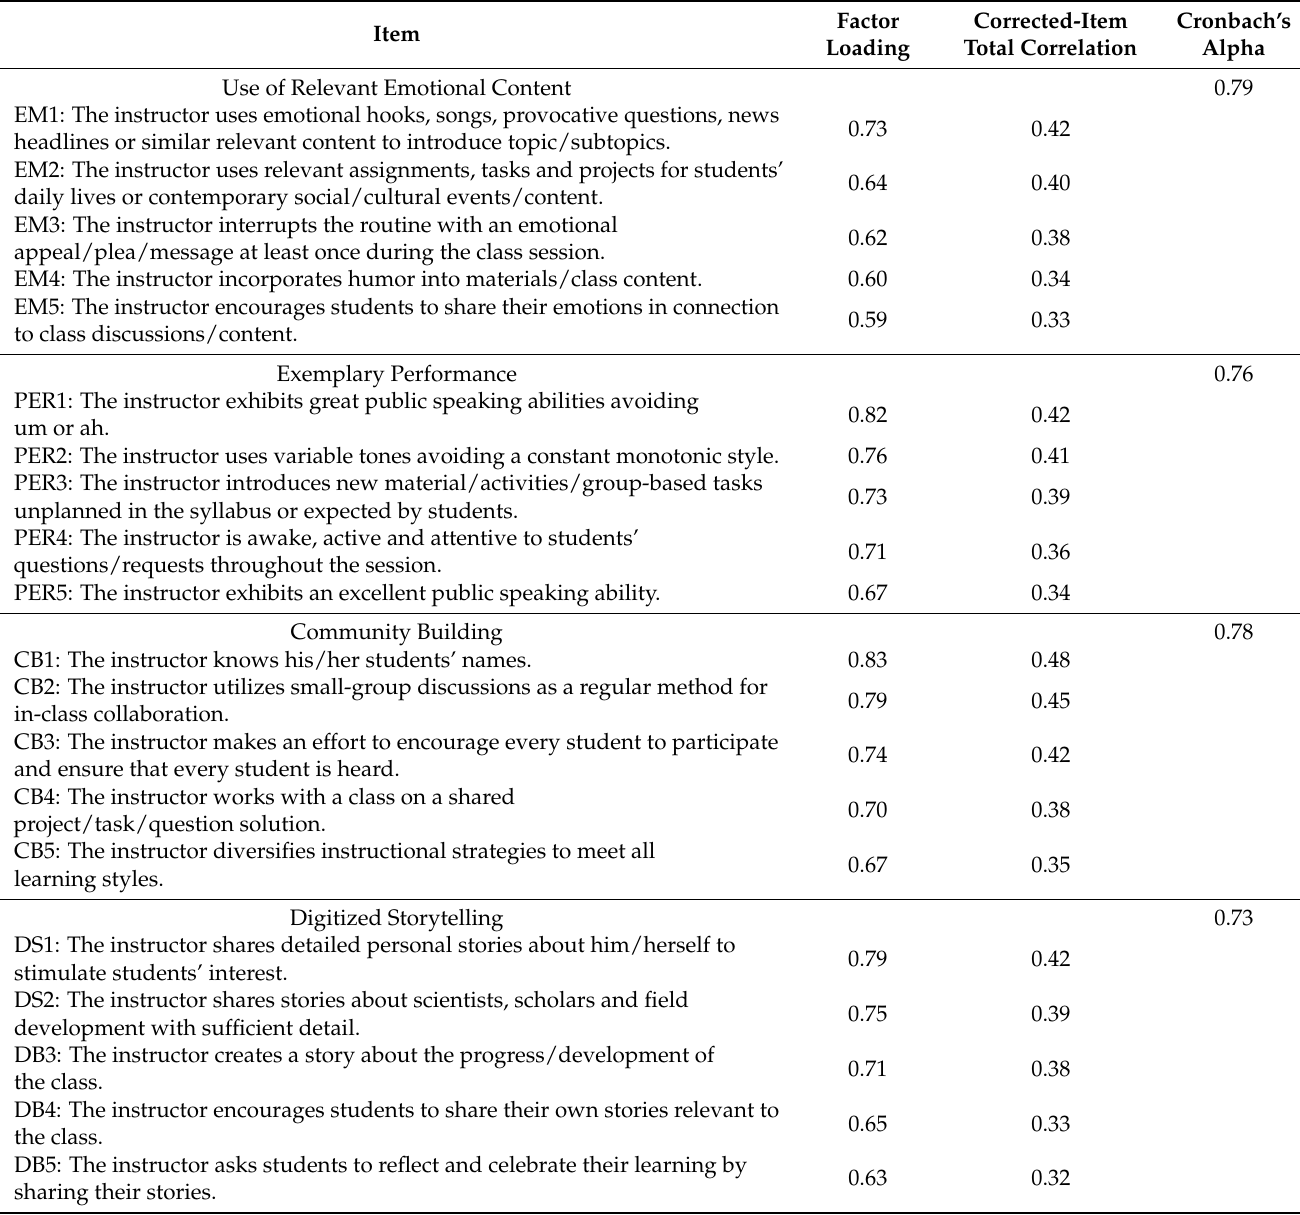
Table 1. The items, their validity and reliability metrics.